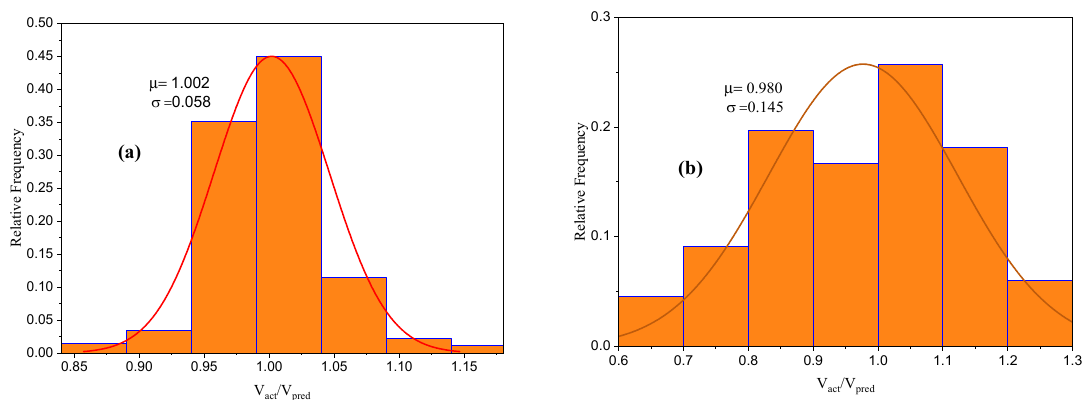
Figure 7. Histogram for V act /V pred (case 1): ( a ) training set; ( b ) testing set.